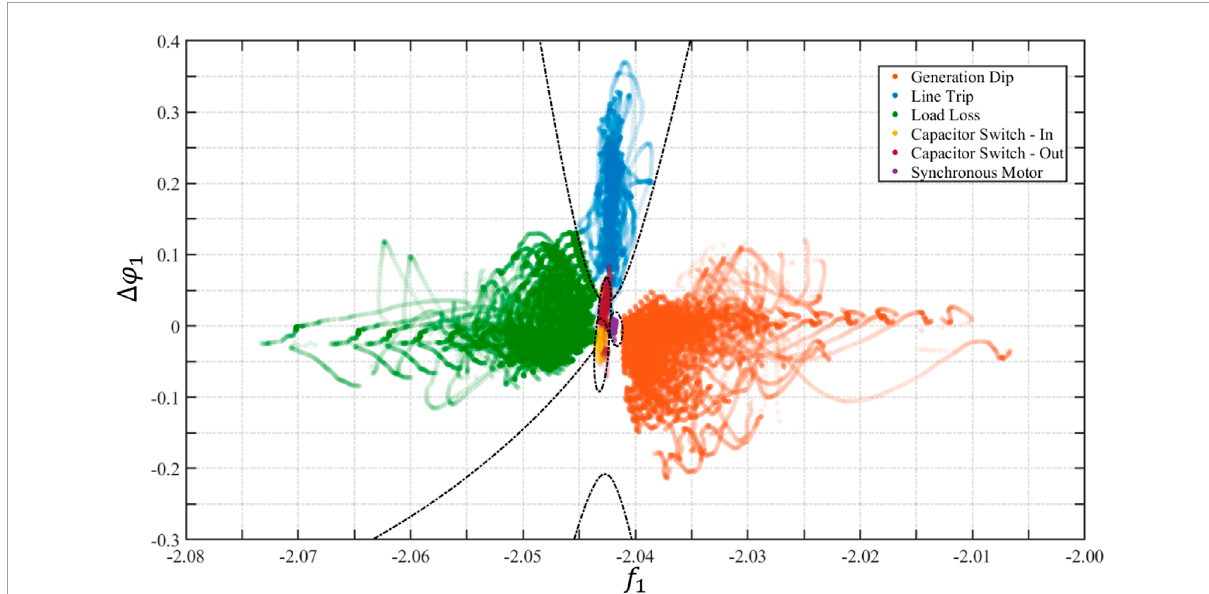
FIGURE 4 Conceptual two-dimensional results for the calculated event type class boundaries for the six event types included in the event database.